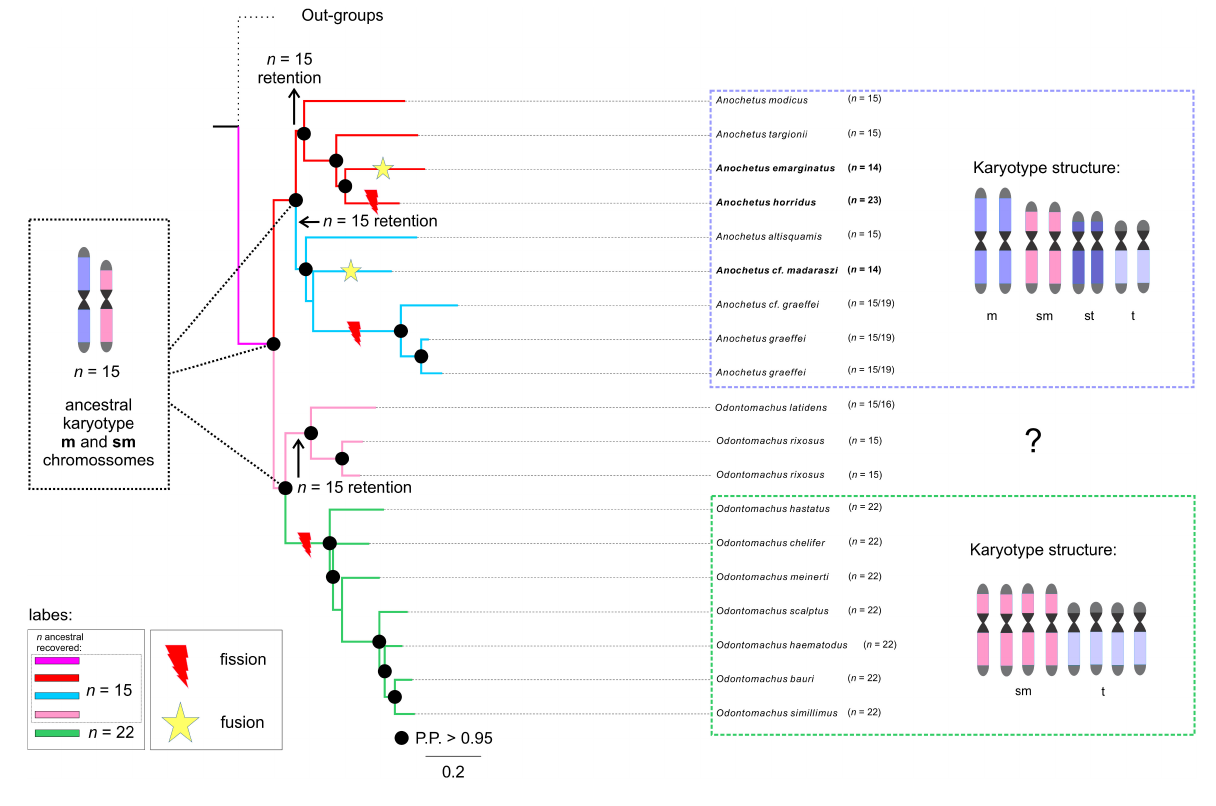
FIGURE 3 | Chromosome number evolution and inferred ancestral chromosome state in the trap-jaw ants inferred under Bayesian and Maximum likelihood optimization. Number at the nodes and respective colors (see label) present the inferred ancestral haploid chromosome. Numbers at the tips are the known haploid chromosome numbers of species. At right of each clade of Anochetus and Odontomachus are depicted the general chromosome morphology comprising the karyotypes. At each branch are highlighted the likely rearrangements undergone during karyotype evolution (see “Discussion” for